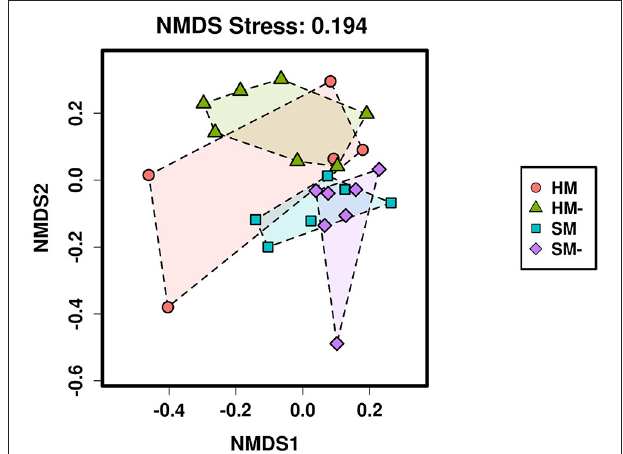
FIGURE 2 | Plot of the non-metric multidimensional scaling ordination of Bray-Curtis distances for the four sampled biocrust habitats. HM, hypolithic moss biocrust; HM-, hypolithic microbial biocrust; SM, surface moss biocrust; SM-, surface microbial